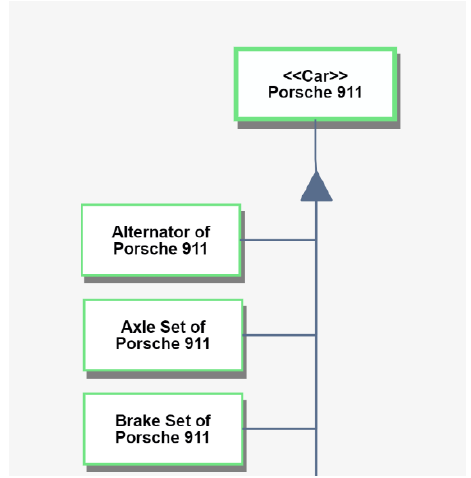
Figure 9. Stereotype naming convention example.